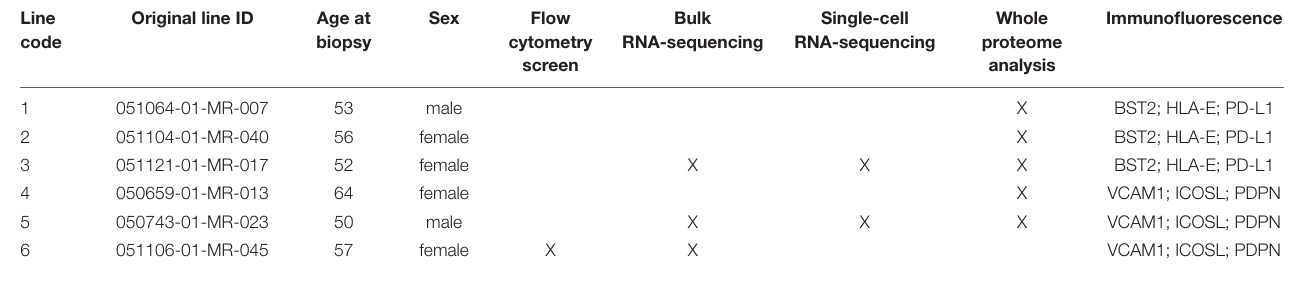
TABLE 2 | Identification code assignment and demographics of hiPSC-line